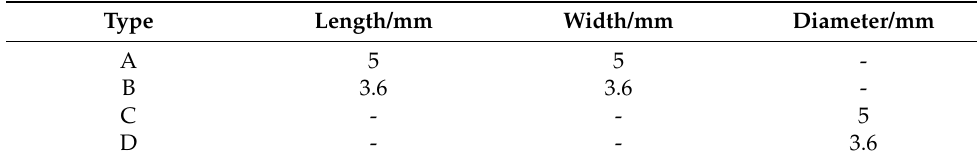
Table 3. Experimental results of pressure loading on chips with different sizes.